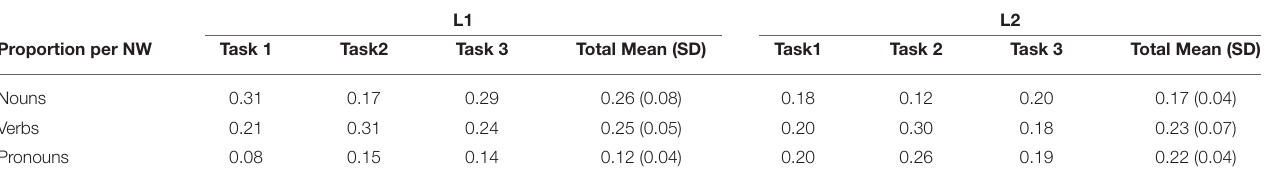
TABLE 5 | Proportion of nouns, verbs and pronouns per narrative words (NW) produced in personal narrative (task1), picture description (task 2) and story retell (task 3) in L1 and L2. L1 L2 Proportion per